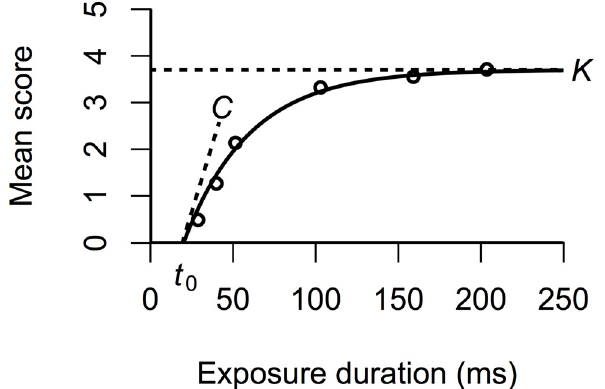
Fig 1. A TVA model fitted to hypothetical data. The data pattern approximates an exponential function, with a steep rise that gradually asymptotes at a certain value. This value is the estimate for VSTM storage capacity , or K . The threshold ( t 0 ) and processing speed ( C ) parameters are defined as the x-axis intercept of the fitted function and the tangent to that function at the intercept,